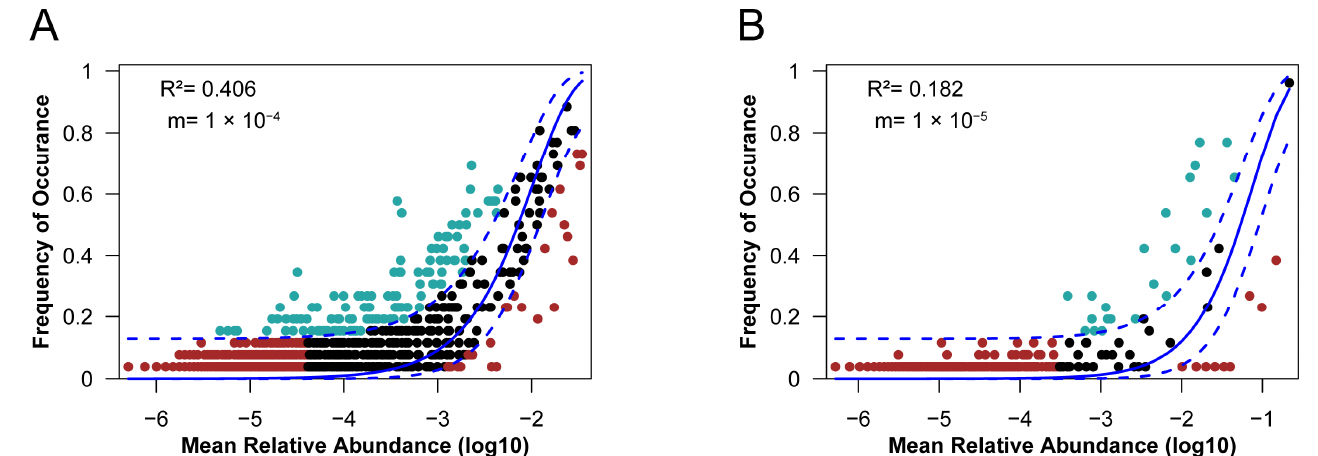
Figure 2. Fits of the neutral model to the produced water sample. ( A ) fit of the neutral model to the bacterial community. ( B ) fit of the neutral model to the archaeal community. Each point represents a different ASV. The solid line represents the predicted occurrence frequency of ASVs, and the dashed line represents the 95% confidence interval around the model prediction. Green points, ASVs over-represented; red points; ASVs under-represented; black points, ASVs neutrally-distributed.